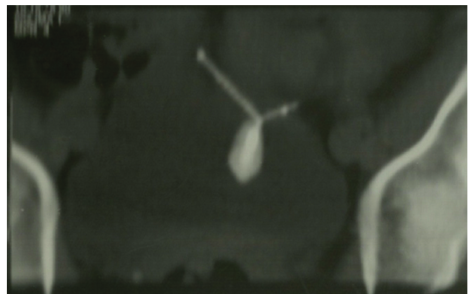
Figure 2: Pelvic helical computed tomography revealed a metallic foreign body partially located intravesically with adjacent calcifica- tion.